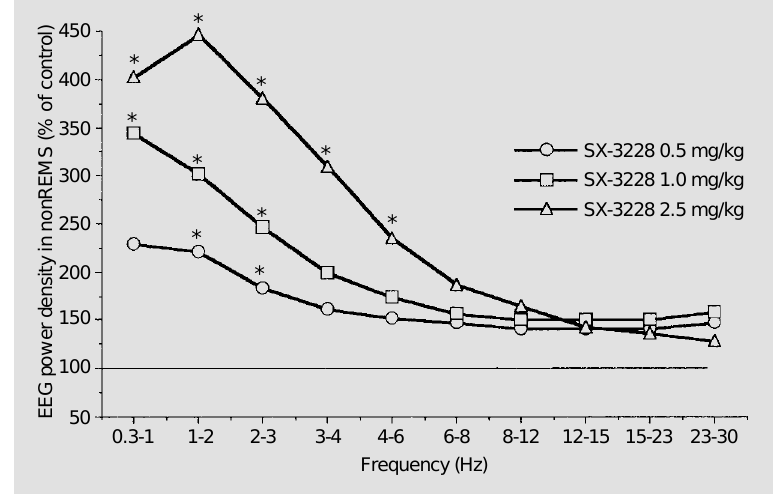
Figure 3 - Effect of SX-3228 on the mean EEG power density of nonREMS (non-rapid-eye- movement sleep) (relative to baseline) during the dark period of the light-dark cycle. The curves indicate mean values of successive frequencies which are reported as percent of the placebo reference value (= 100%) during a 6-h period. SX-3228 significantly and dose- dependently increased power density in the delta and theta regions ( * P<0.05; Newman- Keuls